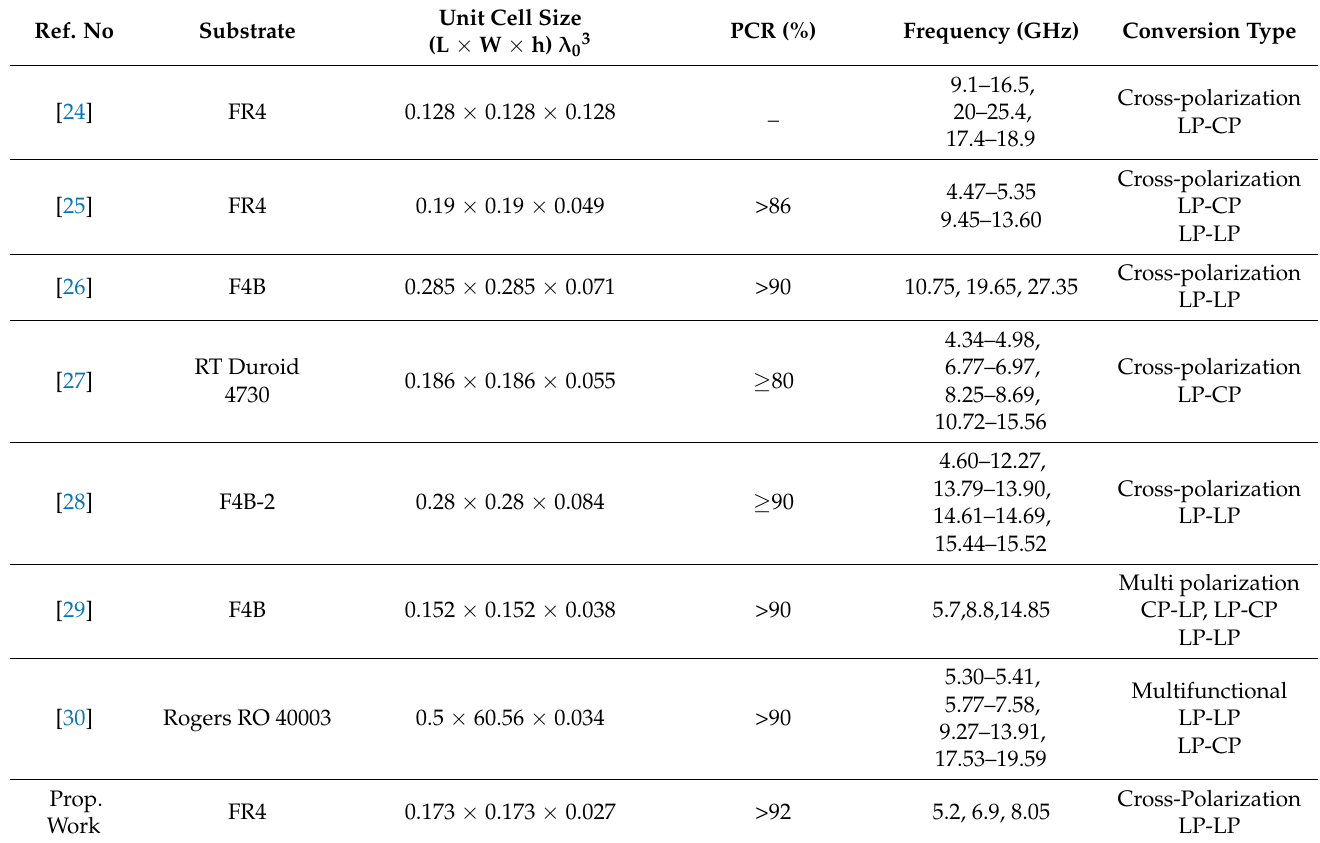
Table 1. Comparison with other related